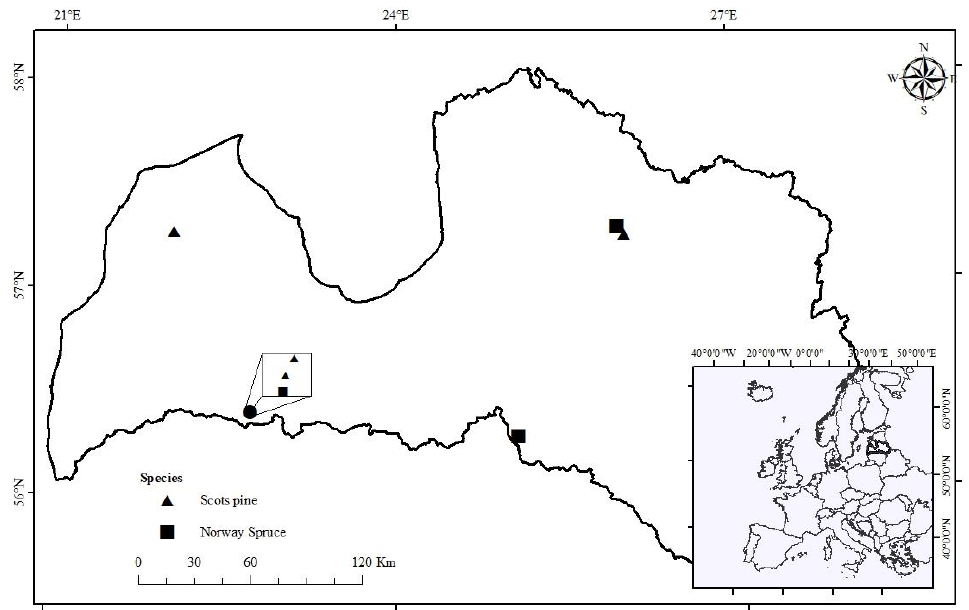
Figure 1. Distribution of sample stands with old-growth Scots pine ( , Pinus sylvestris ) and Norway spruce ( (cid:4) , Picea abies ) in hemiboreal Latvia.